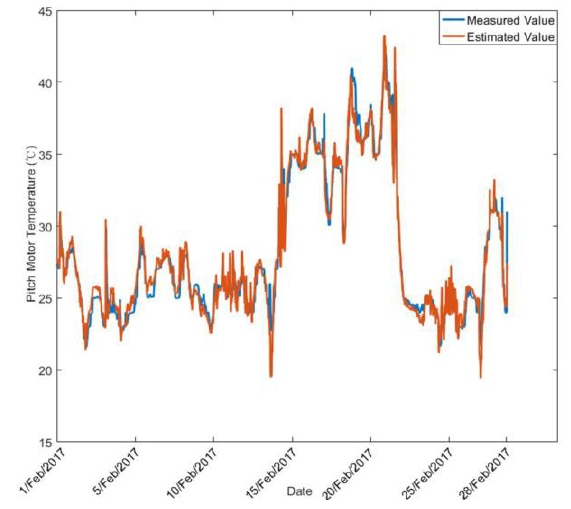
Figure 3. The comparison of the model output and the actual temperature.